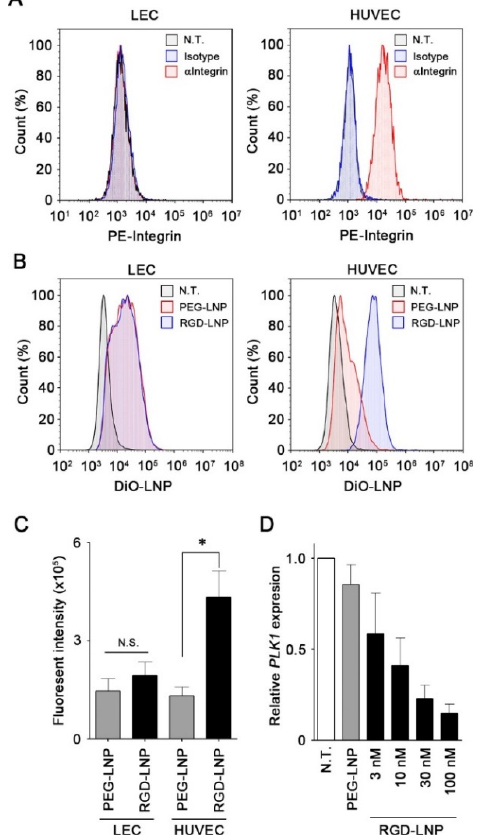
Figure 1. In vitro PLK1 knockdown by RGD-LNP in human endothelial cells expressing integrin. ( A ) Representative histograms based on flow cytometric analysis for LEC and HUVEC stained with the control antibody or anti-integrin antibody. ( B ) Representative histograms based on flow cytometric analysis of the uptake of PEG-LNP or RGD-LNP labeled with DiO in LEC or HUVEC. ( C ) Cellular